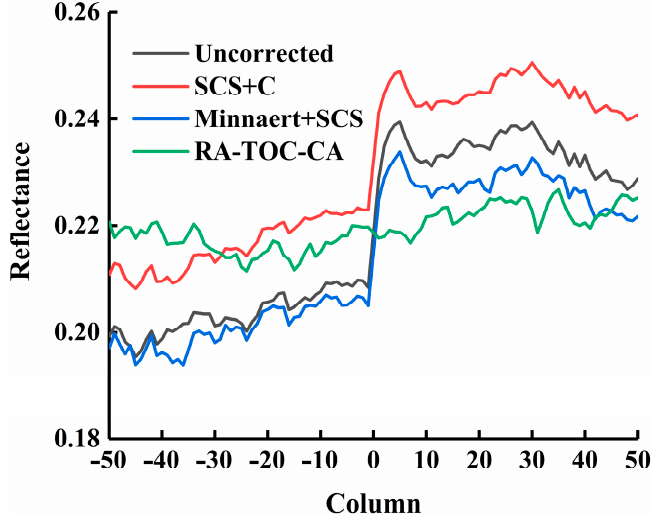
Figure 12. Transitions at the edges of hyperspectral images. The negative semi-axis of the horizontal axis represents the columns of strip A, and the positive semi-axis represents the columns of strip B. The smaller the absolute value of the coordinate, the closer to the seamline.